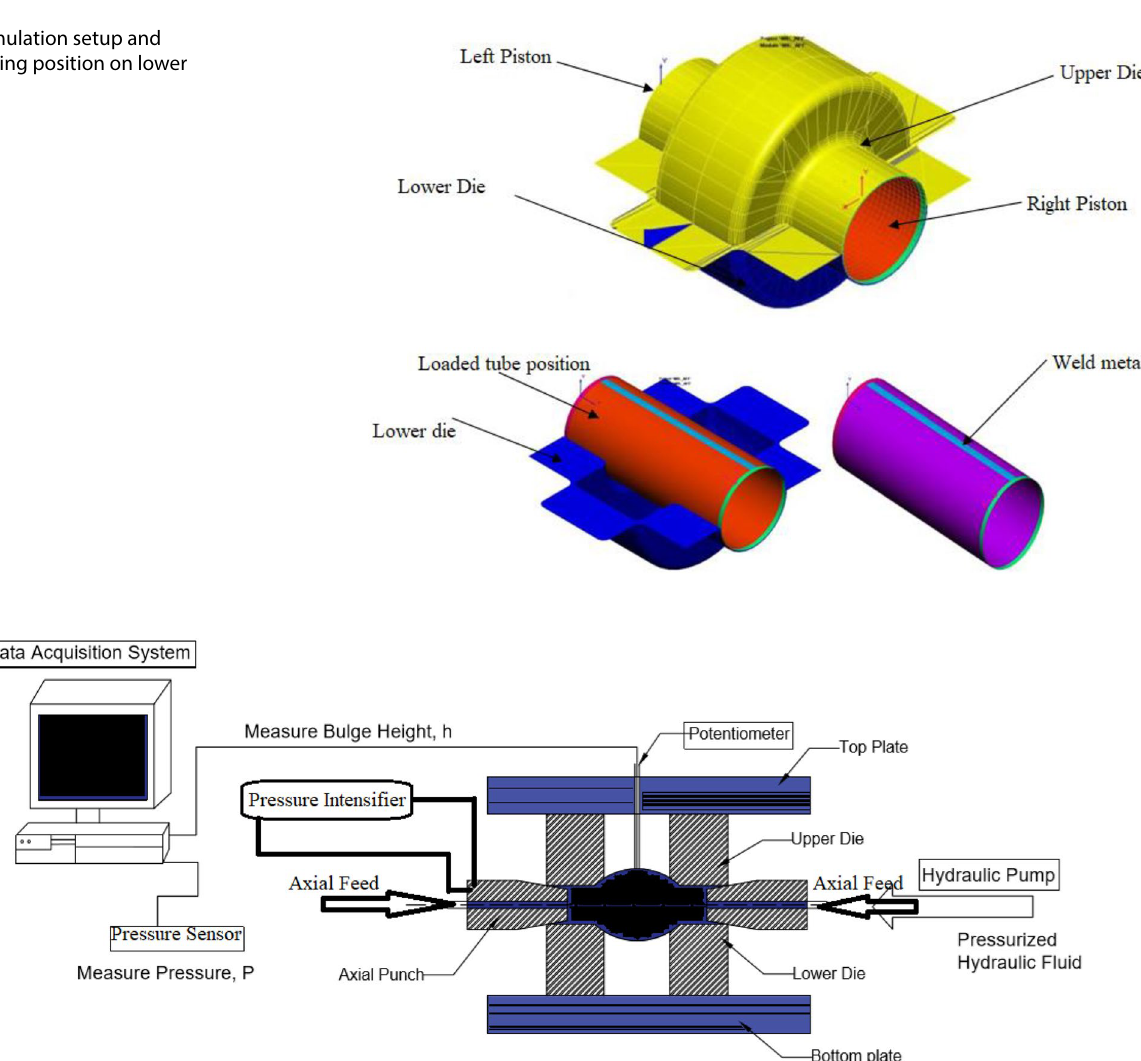
Fig. 1 Steps of simulation